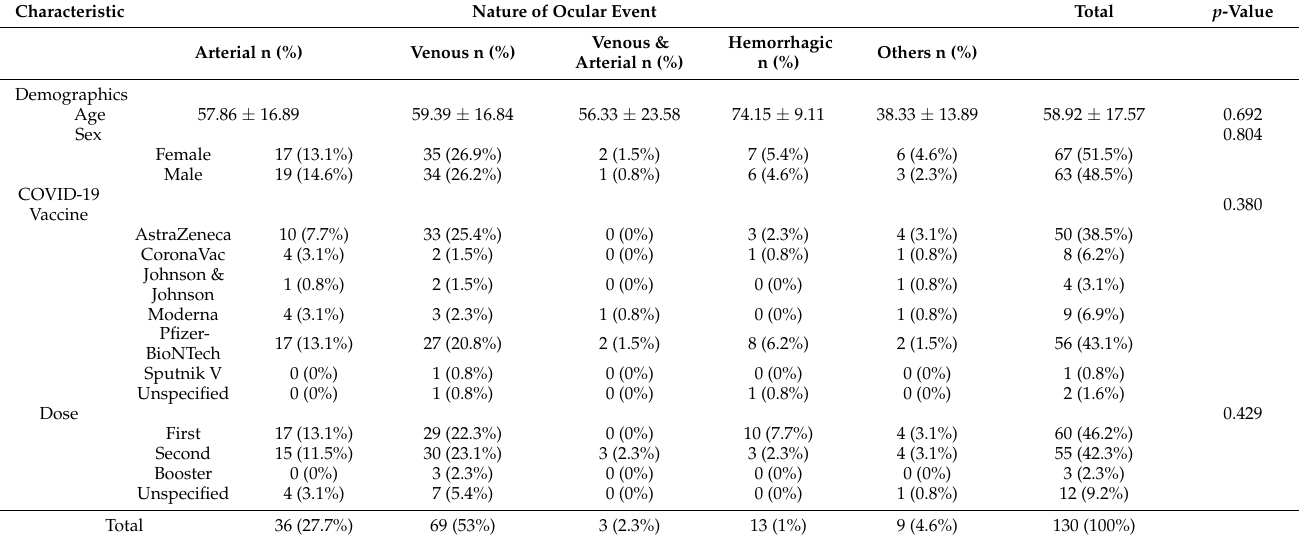
Table 2. Demographic characteristics of the included